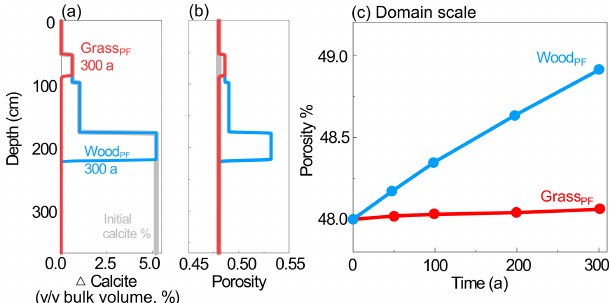
Figure 5. Predicted soil profiles of (a) calcite volume change (cal- cite = initial calcite volume – current calcite volume) and (b) poros- ity after 300 years; (c) predicted temporal evolution of domain- scale porosity in the grassland and woodland. The infiltration rate is